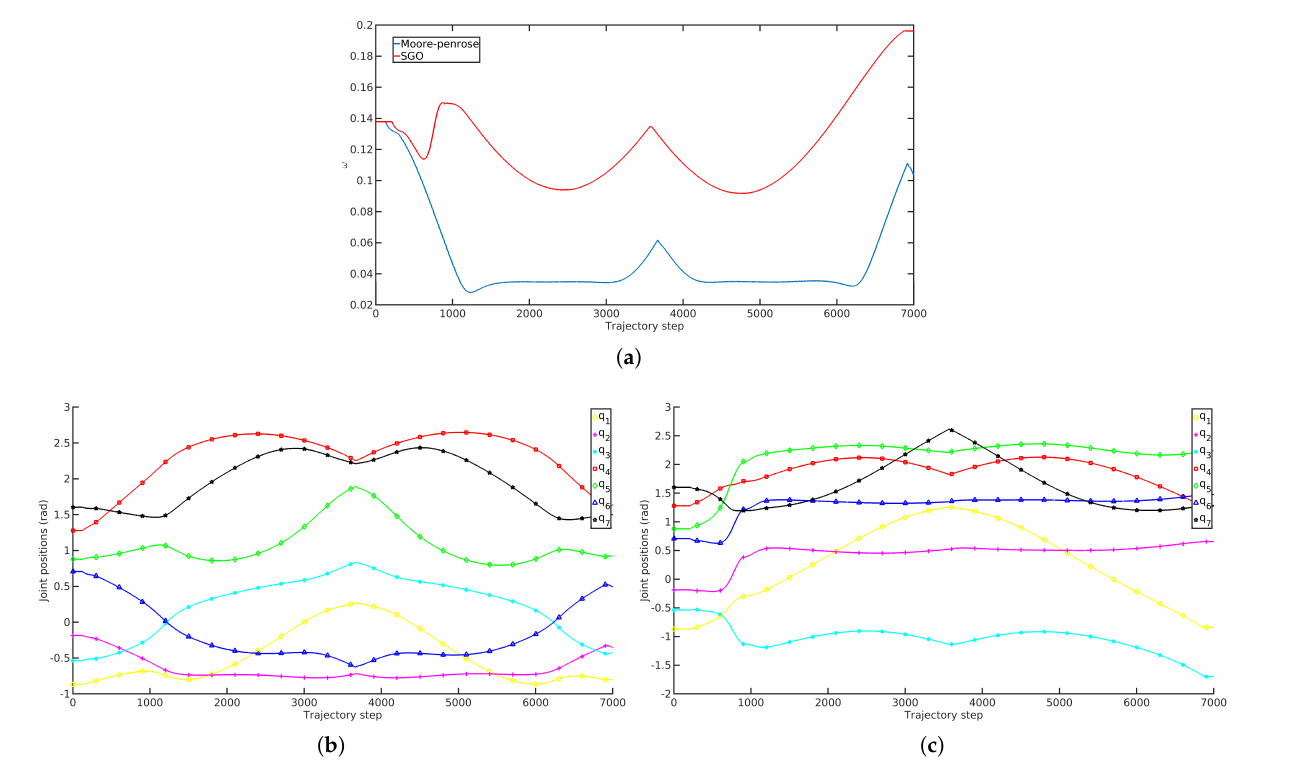
Figure 4. Real polishing experiment with the Sawyer robot: ( a ) Manipulability comparison: attained manipulability evolution of the traversed path illustrated in Figure 3, with the proposed SCO scheme shown in red (top line), and the “Simple Case” Moore–Penrose solution depicted in blue (bottom line). Corresponding ( b ) “Simple Planner” trajectory evolution, and ( c ) Evolution of joint trajectories using the SCO